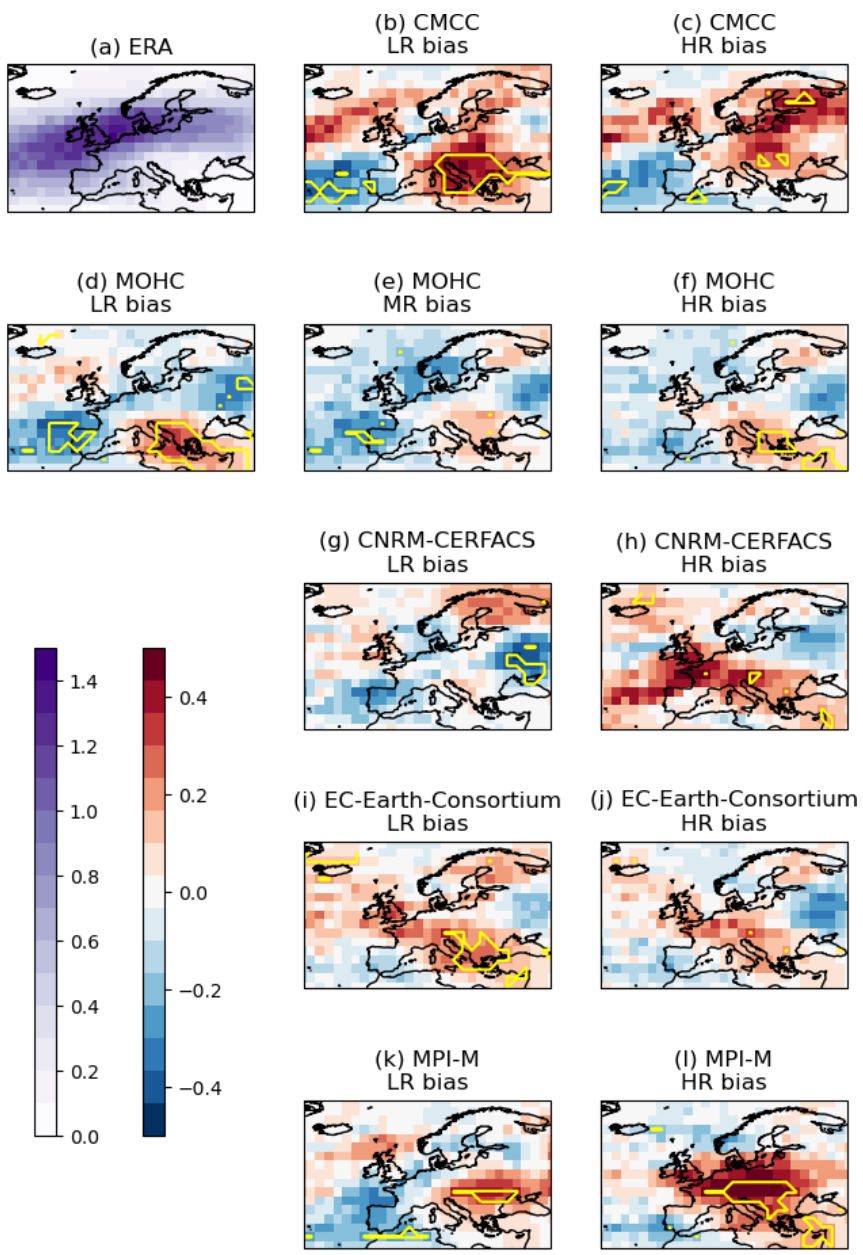
Figure D2. As for Fig. D1 but for severe storms only (LI > 1 × 10 6 ).